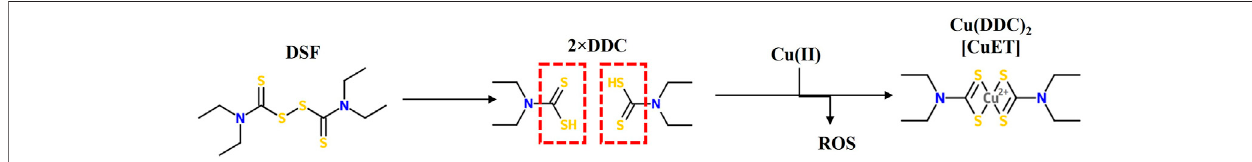
FIGURE 1 | The structure of Disul fi ram (DSF), its metabolite diethyldithiocarbamate (DDC) and its complex with copper Cu(DDC) 2 or (CuET). Intact thiol groups in DS or DDC are indispensable for the chelation of DS or DDC with copper a reaction that results in the generation of reactive oxygen species